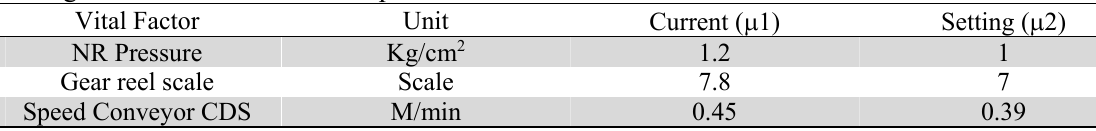
Vital Factor Unit Current (  ) Setting (  ) NR Pressure Kg/cm 2 1.2 1 Gear reel scale Scale 7.8 7 Speed Conveyor CDS M/min 0.45